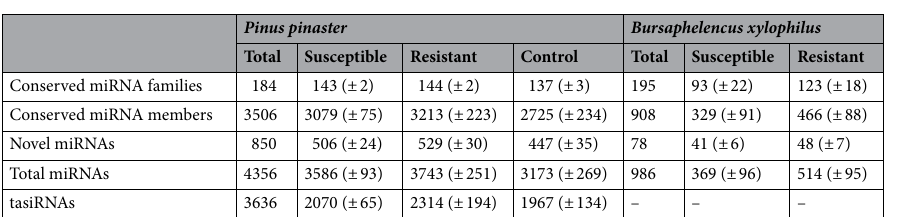
Table 2. Numbers of small RNAs detected in P. pinaster and PWN, B. xylophilus . Values for susceptible, resistant and control samples represent the mean of the biological replicates.